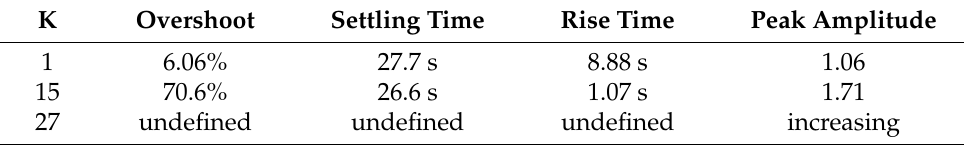
Table 5. Head control system responses at different gains.